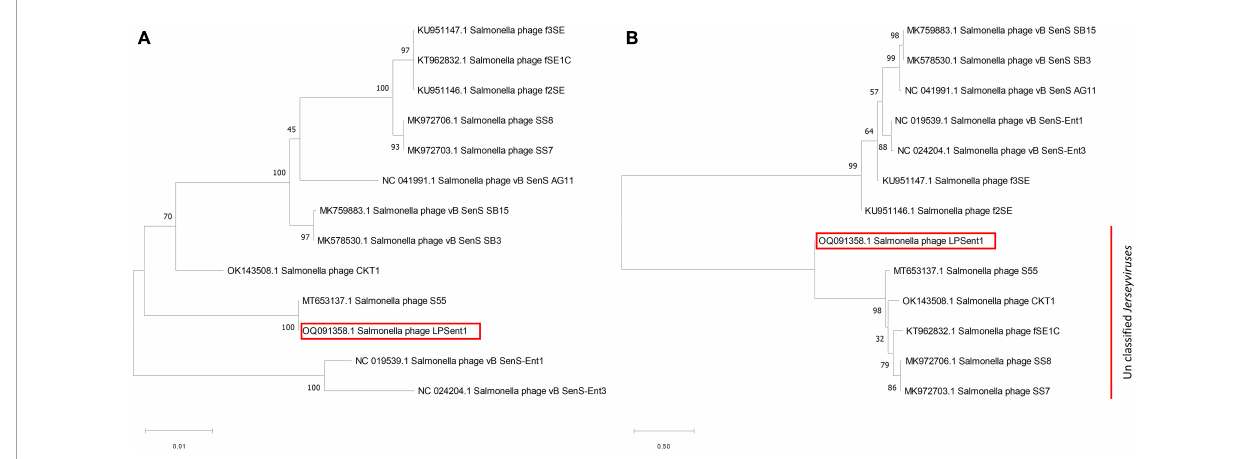
FIGURE5 Neighbor-joining phylogenetic tree based on (A) terminase large subunit gene, (B) complete genome sequences of phage LPSent1 and related phages in Jerseyviruses. Numbers are shown next to the branches indicated by the percentage of replicate trees of the bootstrap test (1000 replicates).